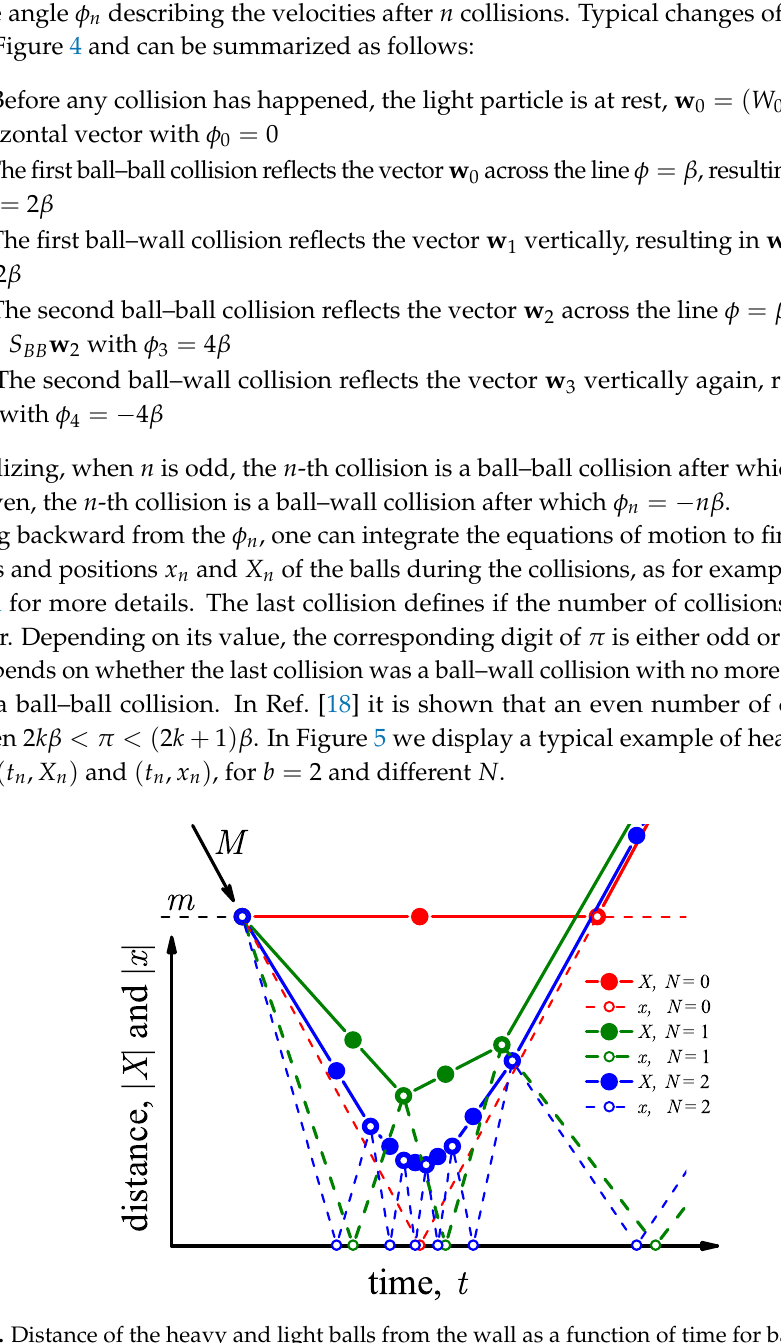
Figure 5. Distance of the heavy and light balls from the wall as a function of time for base b = 2 and different values of N (in arbitrary units). Solid lines and solid symbols, heavy ball X ; dashed lines and open symbols, light ball x